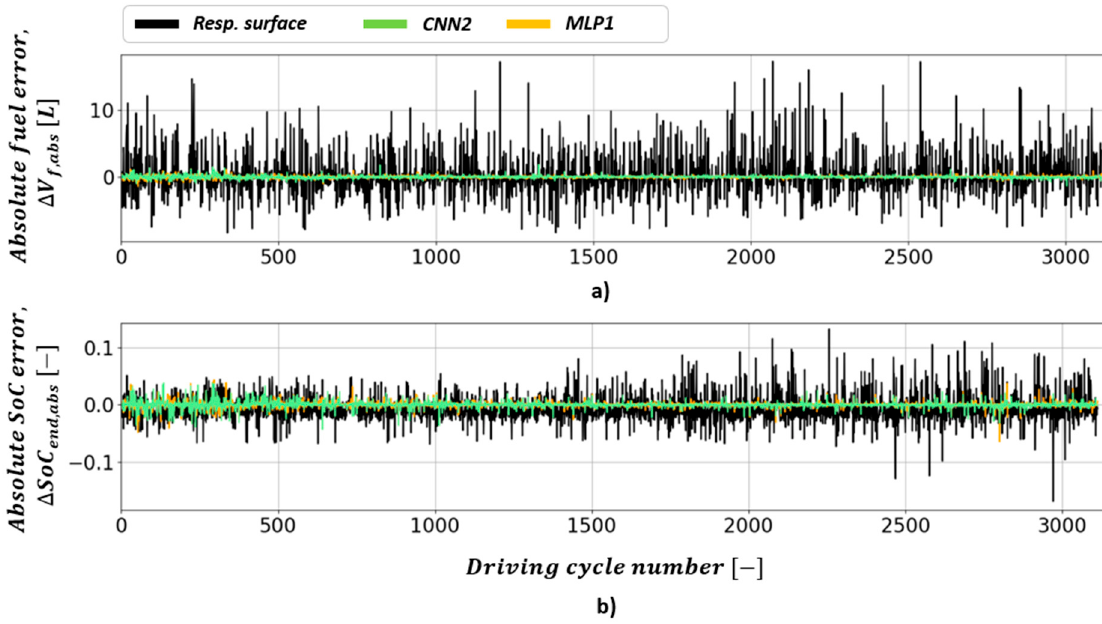
Figure 10. Residuals of predicted fuel consumptions ∆ V f,abs ( a ) and SoC-at-destination ∆ SoC end,abs ( b ) for all driving cycles from the NN testing input dataset.